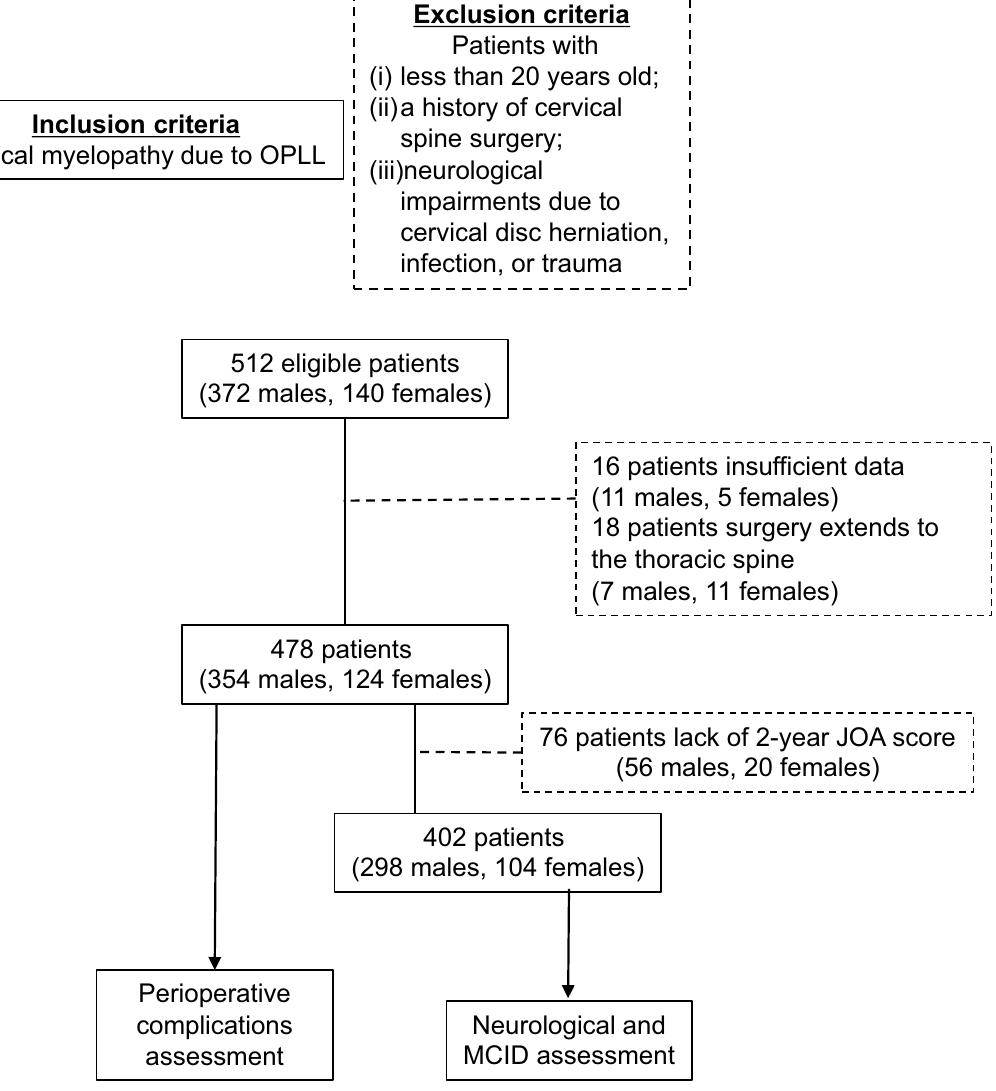
Figure 1. Flowchart of patients through the study. OPLL: ossification of the posterior longitudinal ligament; JOA score: Japanese Orthopedic Association score; MCID: minimum clinically important